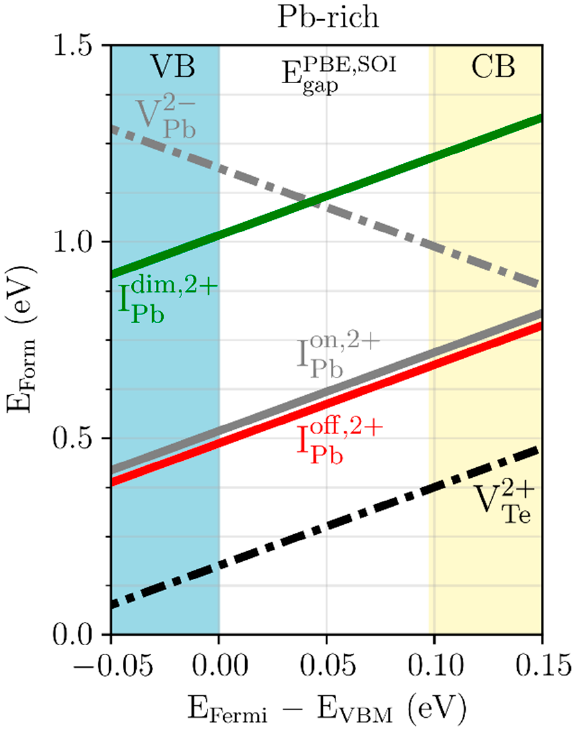
Figure 4. Defect formation energy (E Form ) under the Pb-rich condition of the Pb vacancy (V 2 − : gray dot-dashed line), Te vacancy (V 2 + : black dot-dashed line), as well as the on-centered (I on,2 + : gray solid line), off-centered (I off,2 + : red solid line), and Pb-dimer (I dim,2 + : green solid line) Pb interstitial defects. The x-axis represents the difference between the Fermi level (E Fermi ) and the valence band maximum energy (E VBM ). The yellow region indicates the conduction band (CB), the blue region the valence band (VB), and the white region the PBE energy gap calculated with SOI (E PBE,SOI gap